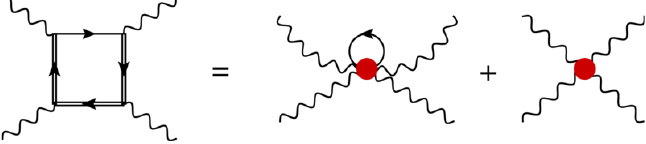
Figure 4 . Examples of BSM contribution arising from heavy particle loops. Double lines represent BSM particles.